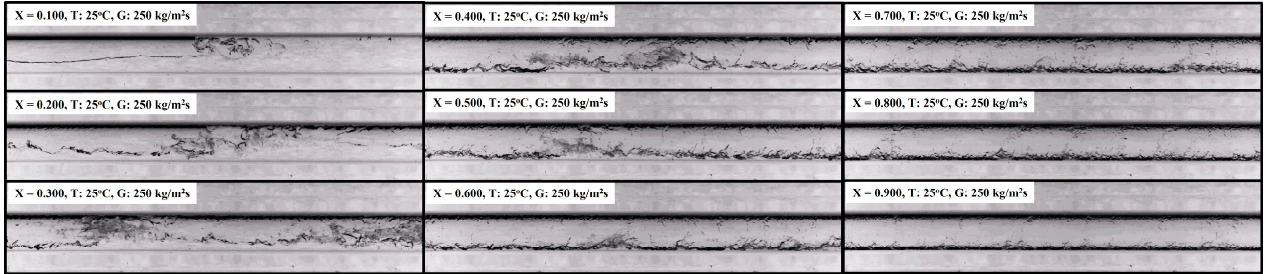
Figure 5. The entire void fraction measurement process for the capacitance sensor; ( a ) FEM analysis and void fraction data reduction from measured capacitance; ( b ) proposed calibration process.